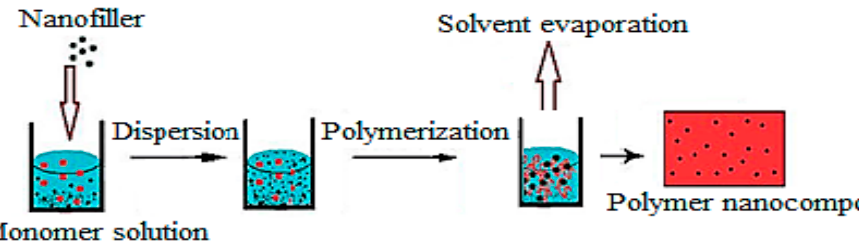
Figure 1. Schematic illustration for the in situ polymerization method (taken from [27]).